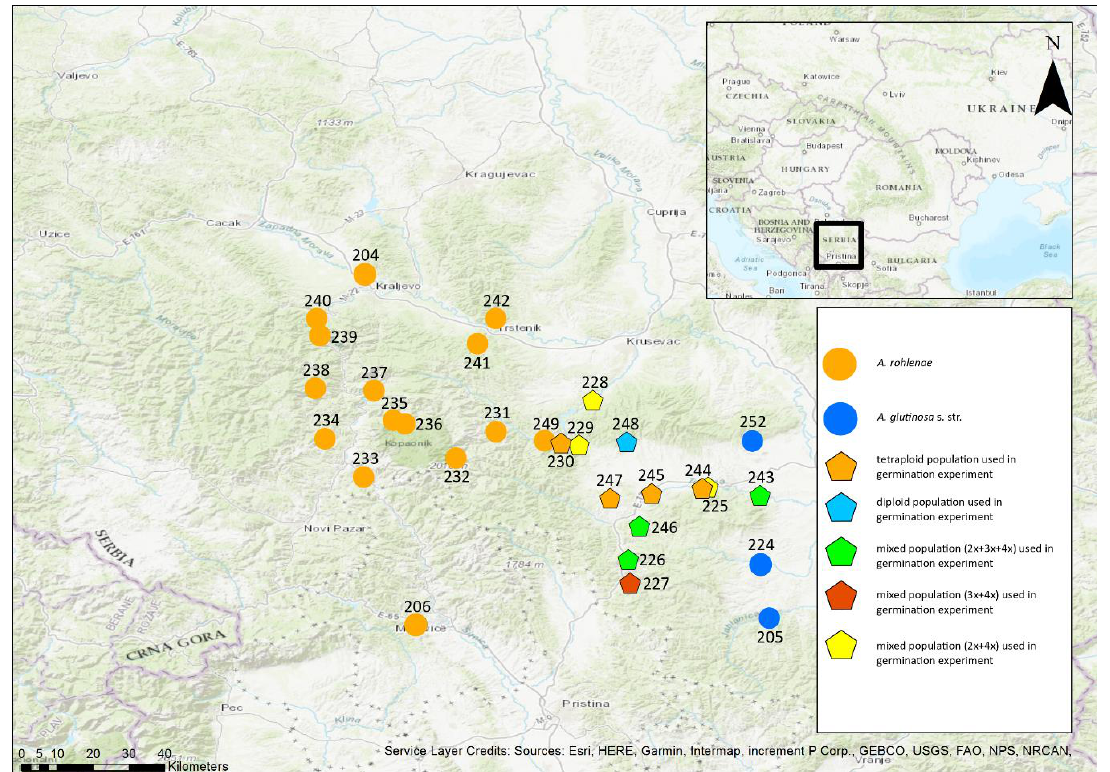
Figure 1. Geographical locations of populations of Alnus glutinosa s. str . , A. rohleane and their triploid